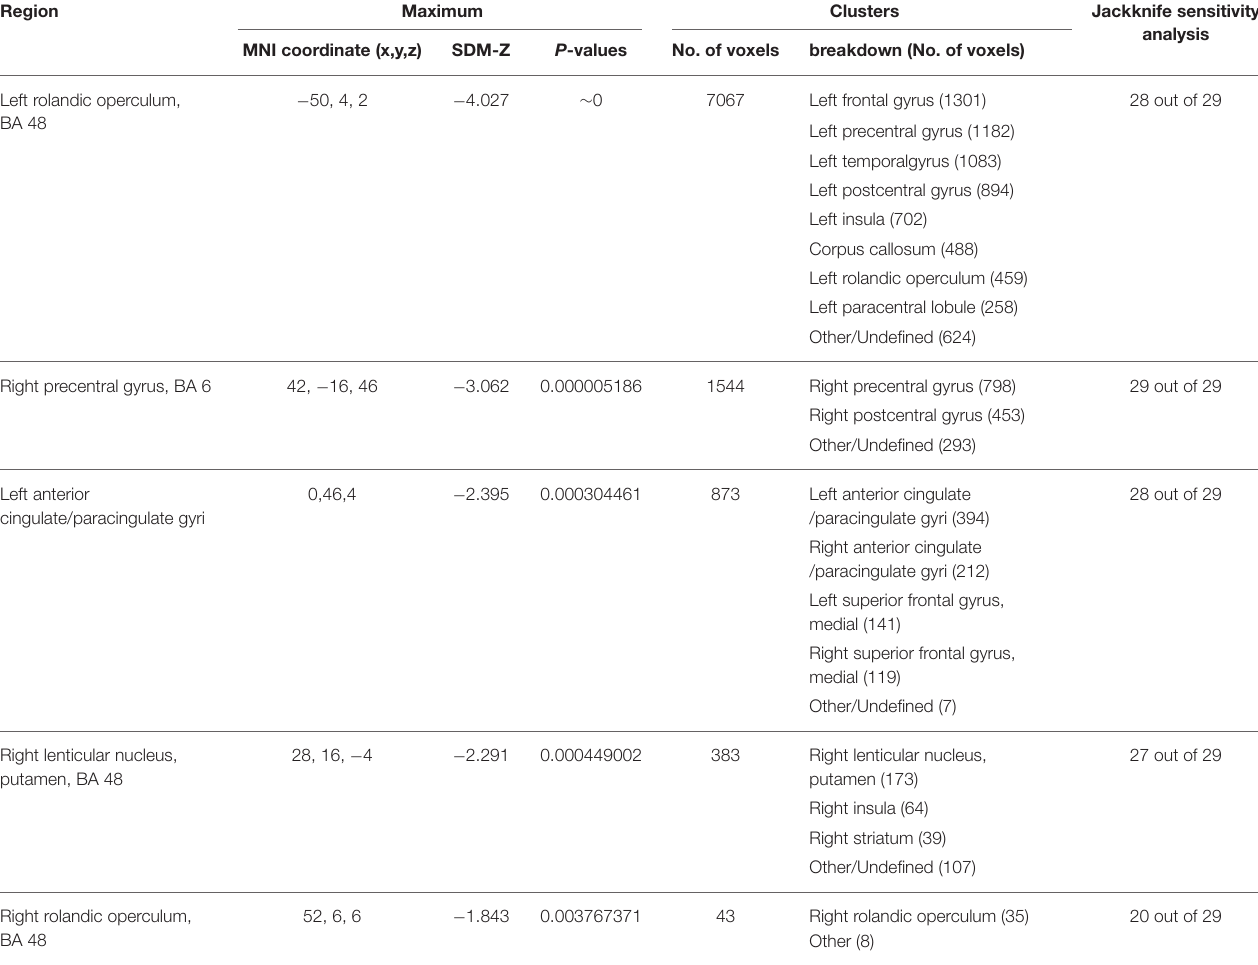
TABLE 2 | Regional differences in GM volume between patients with ALS and HCs.